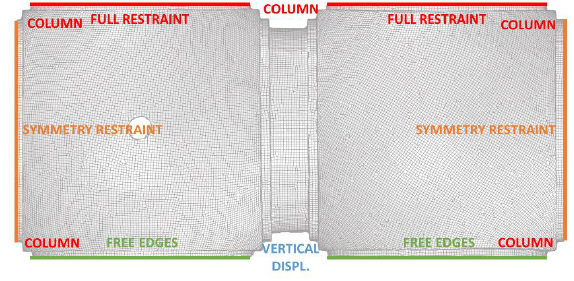
Figure 8. Boundary conditions of the vault.